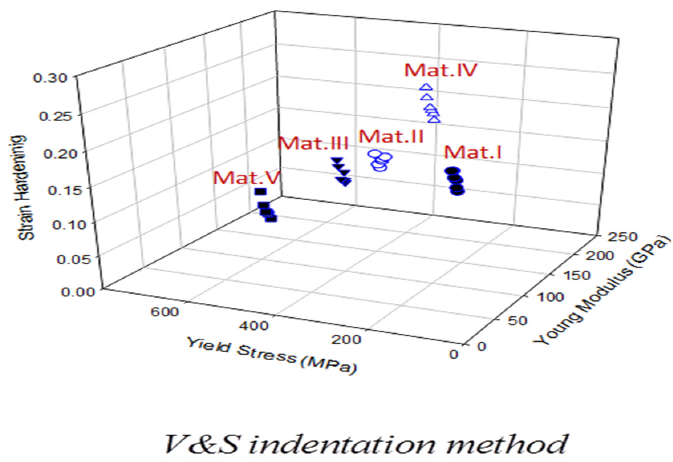
Figure 6. Sensitivity and accuracy results of elastic plastic optimization algorithms (S&B, B&V and V&S). Table 2. Sensitivity and accuracy analysis of the S&B optimization method.